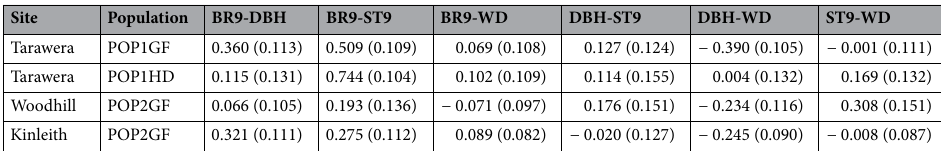
Table 2. Marker-based genetic correlation estimates and their standard errors (in